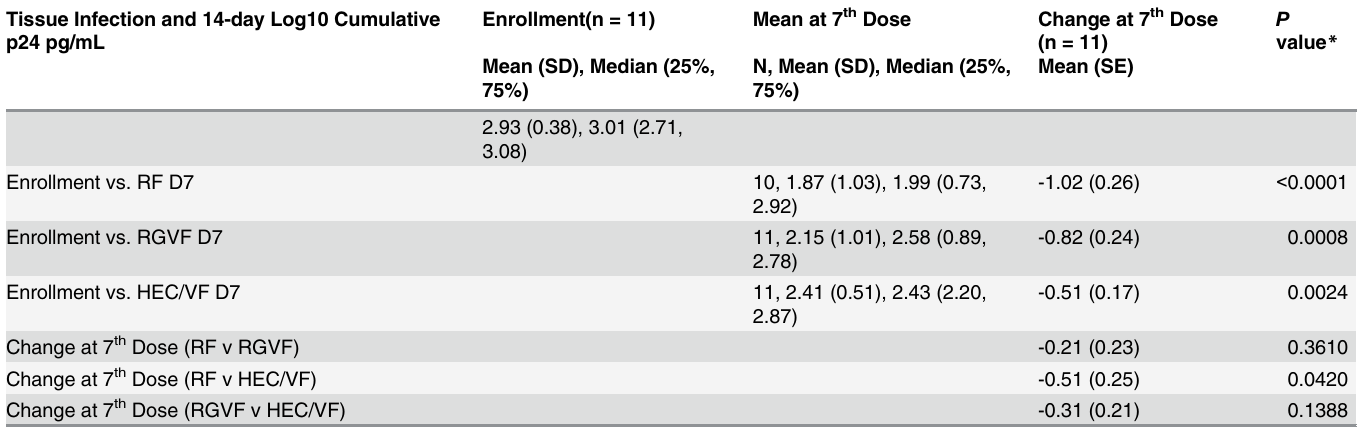
Table 6. Tissue pharmacodynamic